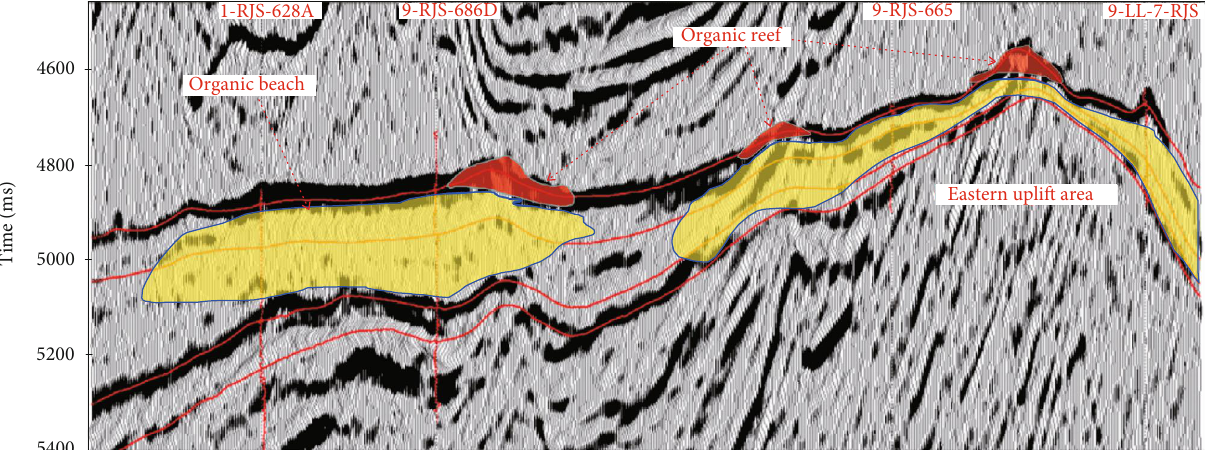
Figure 6: The well-tie seismic cross section in the study area.